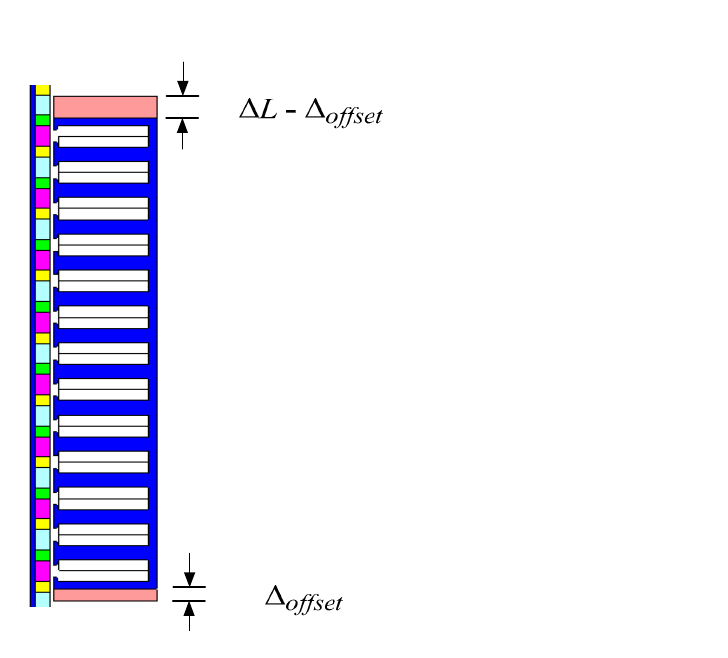
Figure 7. Initial phase adjustment of the end-effect cogging force by offsetting the auxiliary core.